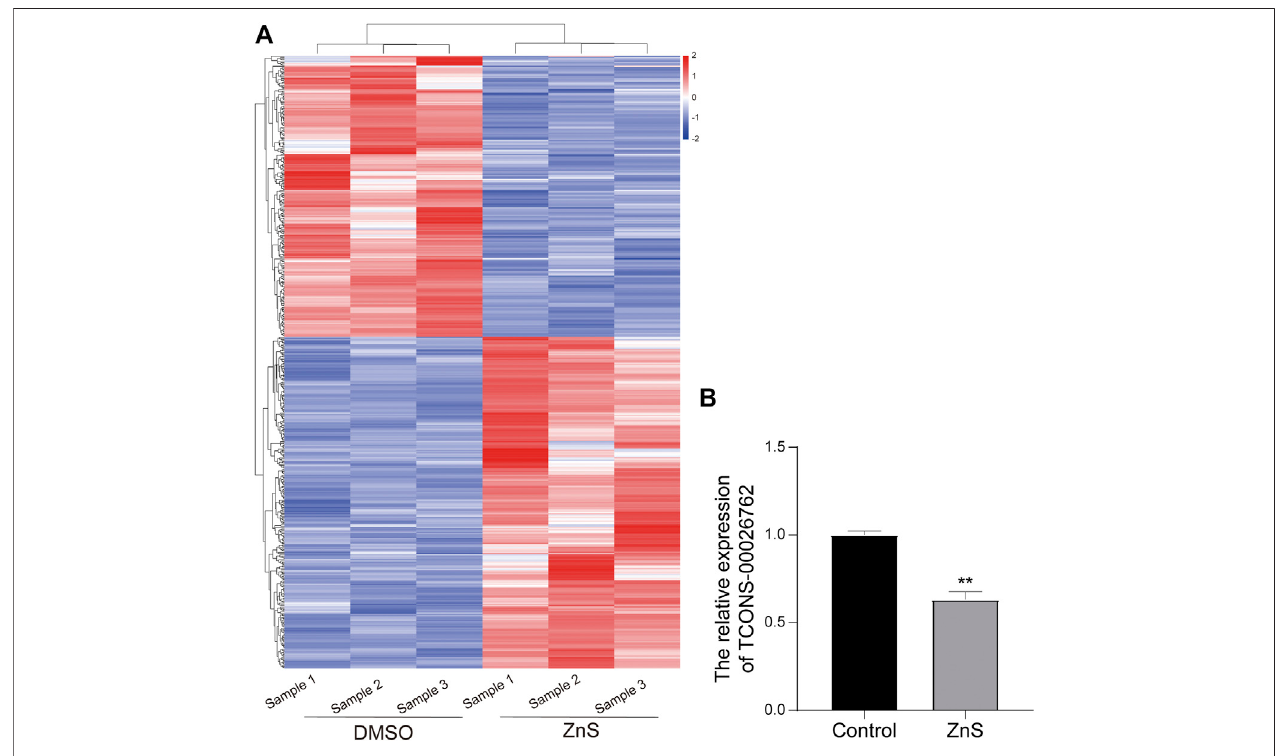
FIGURE 2 | Analysis of differentially expressed lncRNAs treated with ZnS. (A) The heatmap of differentially expressed lncRNAs between DMSO and ZnS groups. (B) The qRT-PCR analysis of TCONS-00026,762 expression. Each trial was replicated at least three times. Data are expressed as mean ± SD, **, p < 0.01.